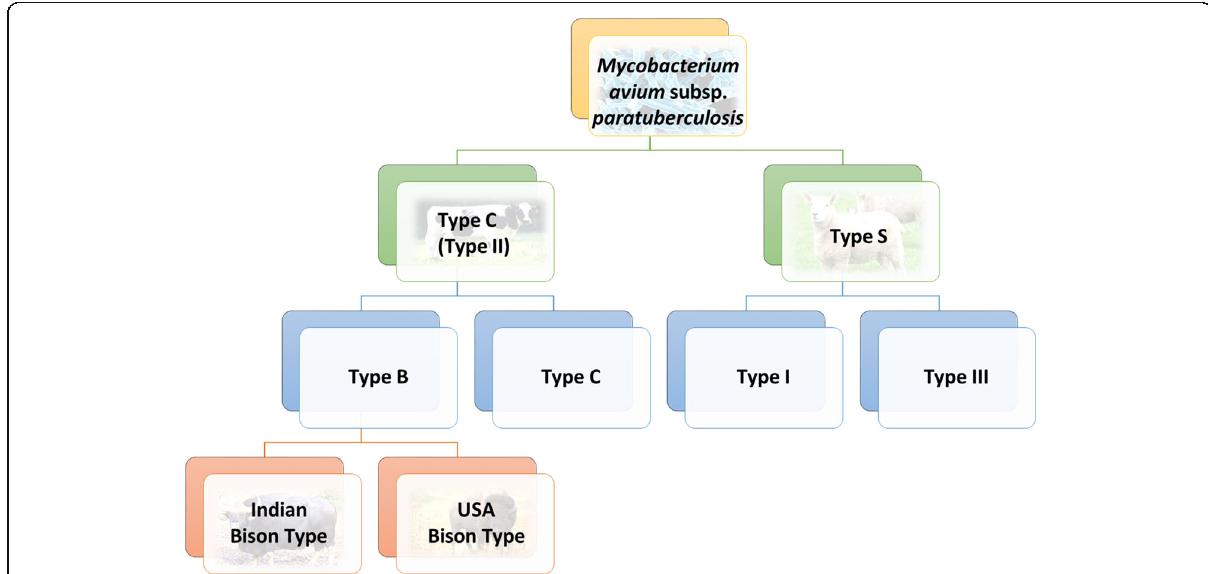
Fig. 1 Nomenclature of Mycobacterium avium subsp. paratuberculosis (Adapted from [64]). There are two major groups of strains; Sheep-type, or Type S, and Cattle Type, or Type C, and an “ intermediate ” Type III, a sub-type of Type S. Type B is a subtype of Type C and is typically isolated from